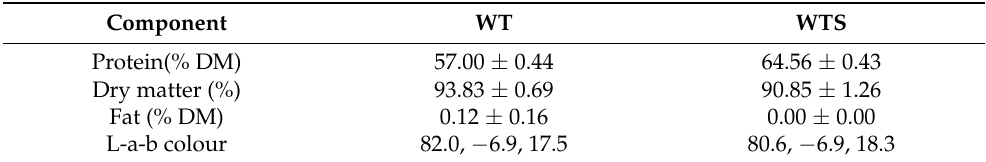
Table 3. Protein concentration, dry matter (DM), fat and L-a-b colour of the WAPC produced (from the twin screw press-based process), n = 2. Here, WT is WAPC without SFE treatment and WTS is WAPC treated with SFE.